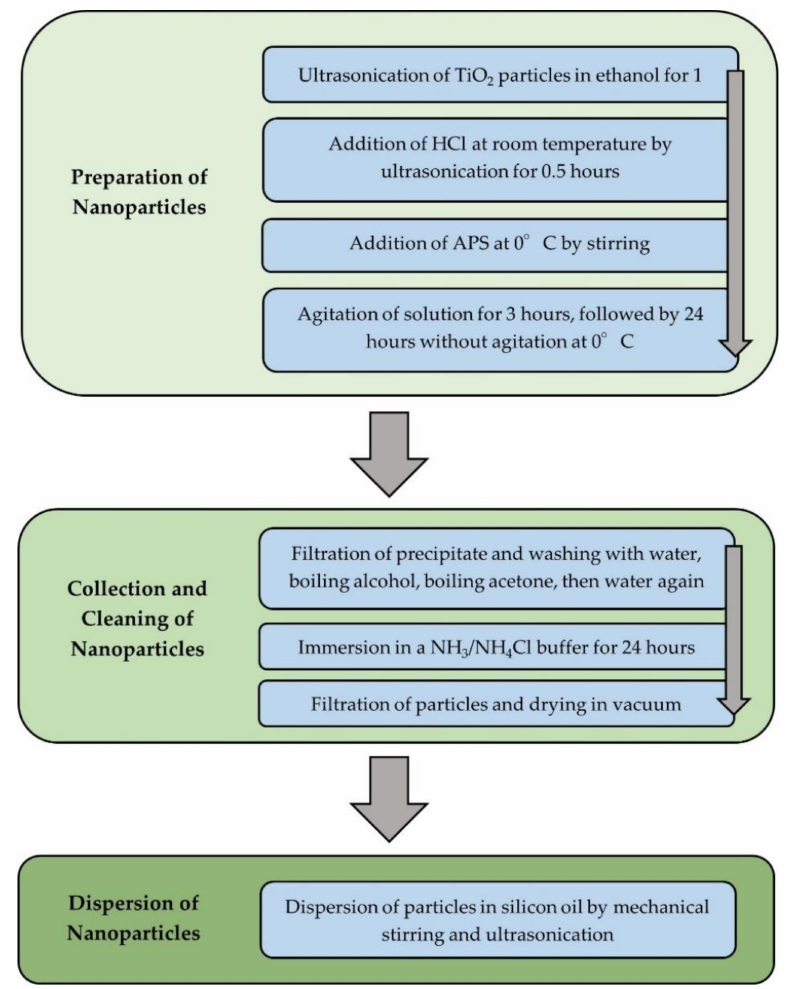
Figure 6. Synthesis of ERF made from PANI and TiO 2 dispersed in silicone oil. Commercially available anatase TiO 2 nanoparticles are well-dispersed in ethanol by ultrasonication for 1 h, followed by the addition of concentrated HCl at room temperature with continuous ultrasonication for 0.5 h. [36]. After 12 h at room temperature, distilled aniline was added through ultrasonication over 0.5 h. The mixture was maintained at 0 ◦ C with a cooler. A solution of ammonium persulfate (APS) in water was dropped into the mixture and rapidly stirred. After being continuously agitated for 3 h under 0 ◦ C, the mixture was then left for another 24 h at 0 ◦ C. The precipitate is filtered and washed with water, boiling alcohol, boiling acetone, and then water again. Then, the particles are immersed in an NH 3 /NH 4 Cl buffer solution for 24 h. After being filtered and dried in a vacuum, the 2D structured PANI/TiO 2 nanosheets are obtained. The nanosheets are blue-brown and appear as particles due to their small diameter [36]. The nanosheets are then dispersed in silicon oil with a mechanical stirrer and ultrasonicated to create the ERF [36]. Figure 6 shows the three main steps of the production process. Consistent with the large variety of ionic EAPs, the steps taken in the synthesis of ionic EAPs vary